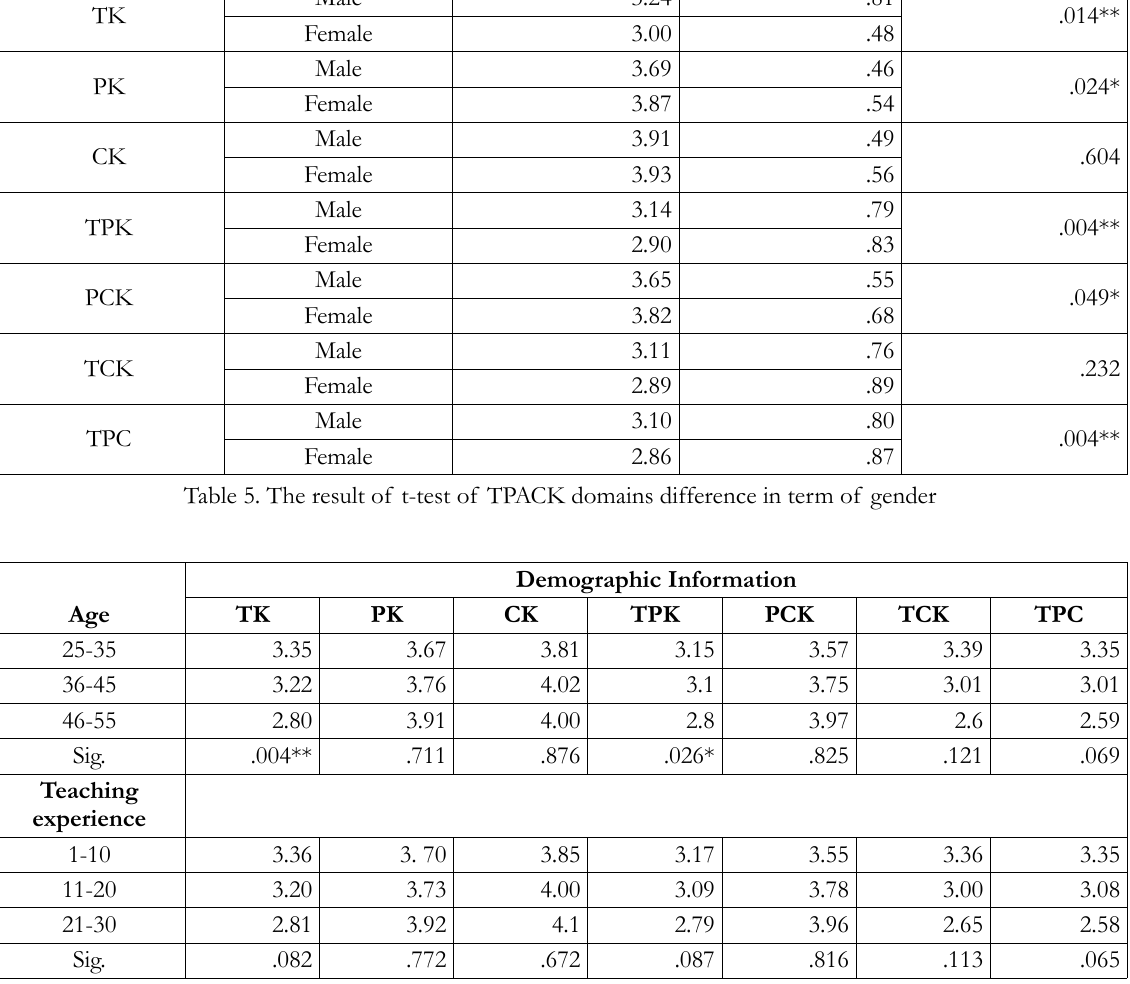
Table 6. Result of ANOVA of TPACK domains difference in term of age and